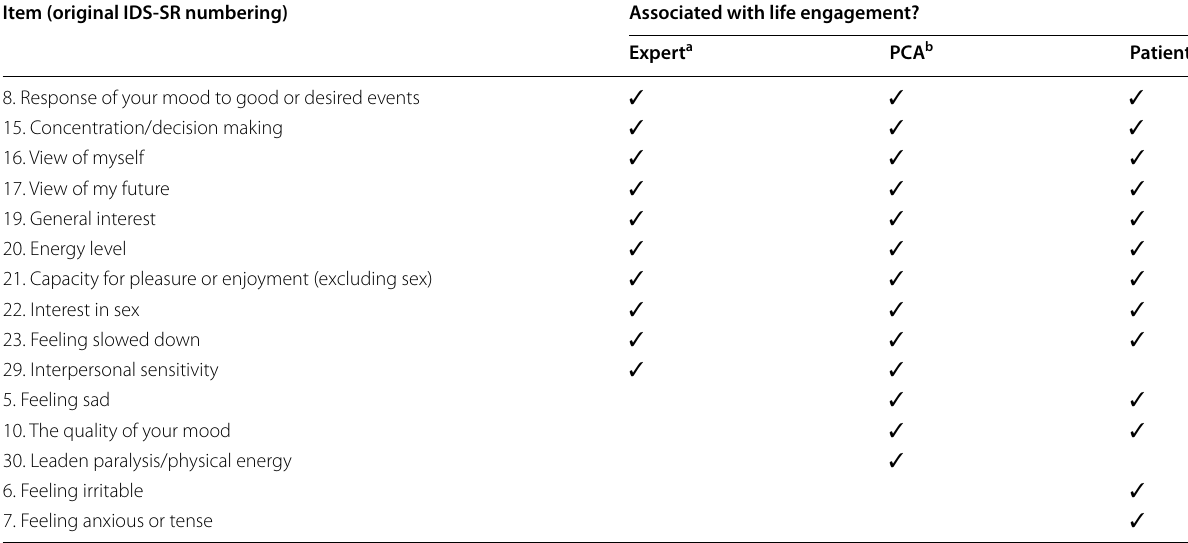
Table 4 Summary of expert, PCA and patient relevance of IDS-SR items to life